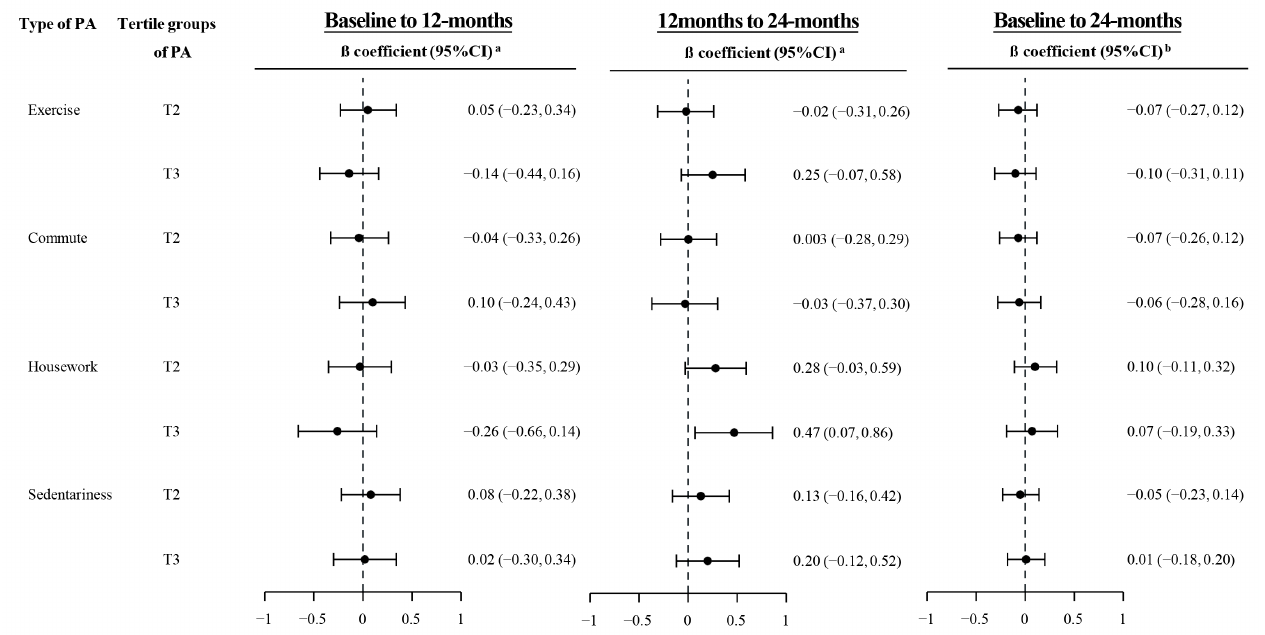
Figure 2. Associations of HbA1c with levels of specific type of PA (Physical Activity). a Two-level mixed regression models with individuals as the level-2 and intervention status as the level-1 observations, and adjusted for age, sex, anti-diabetes drug use or insulin use, duration of diabetes, initial levels of A1c and PA, overall PA level; b Three-level mixed regression models with individuals as the level-3, intervention status as the level-2, and repeated measurements of PA as the level-1 observations, and adjusted for age, sex, anti-diabetes drug or insulin use, duration of diabetes, baseline levels of A1c and PA, and overall PA level.